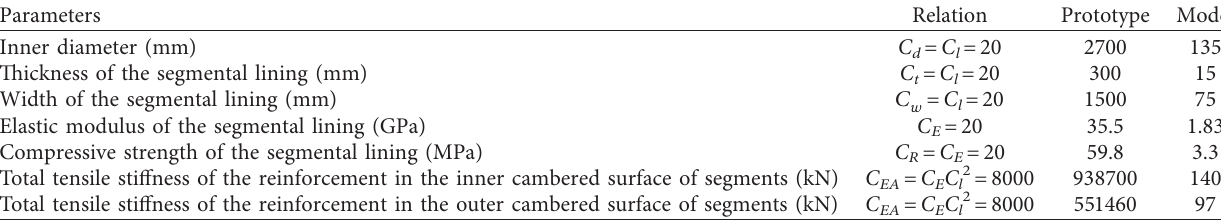
Table 1: Mechanical and geometrical parameters of the model